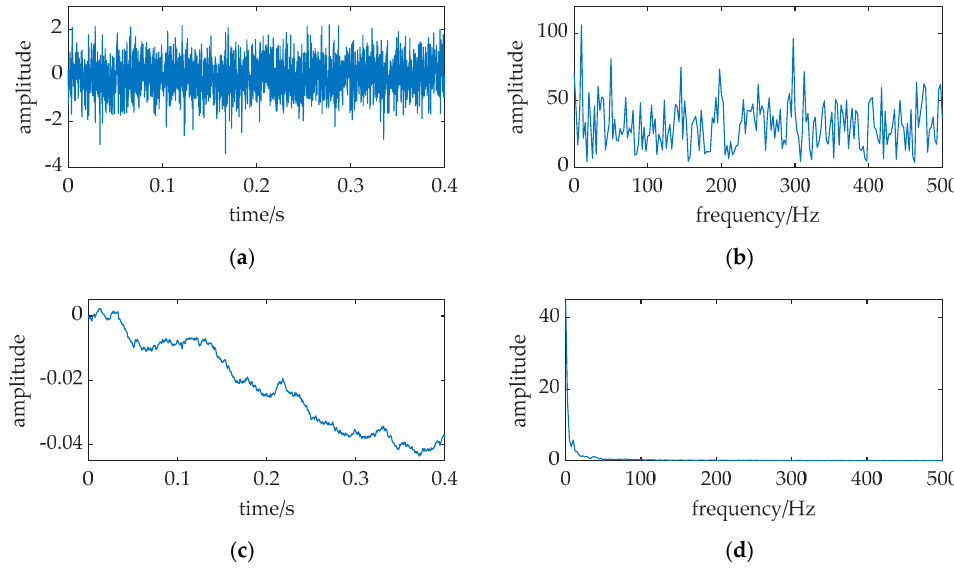
Figure 5. The SR of high-frequency signal. The relative parameters: A = 0.1, f = 10, a = 1, b = 1, D = 0.31, Figure 5. ( a , b ) are the waveform and frequency spectrum of the input; ( c , d ) are waveform and frequency spectrum of the SR